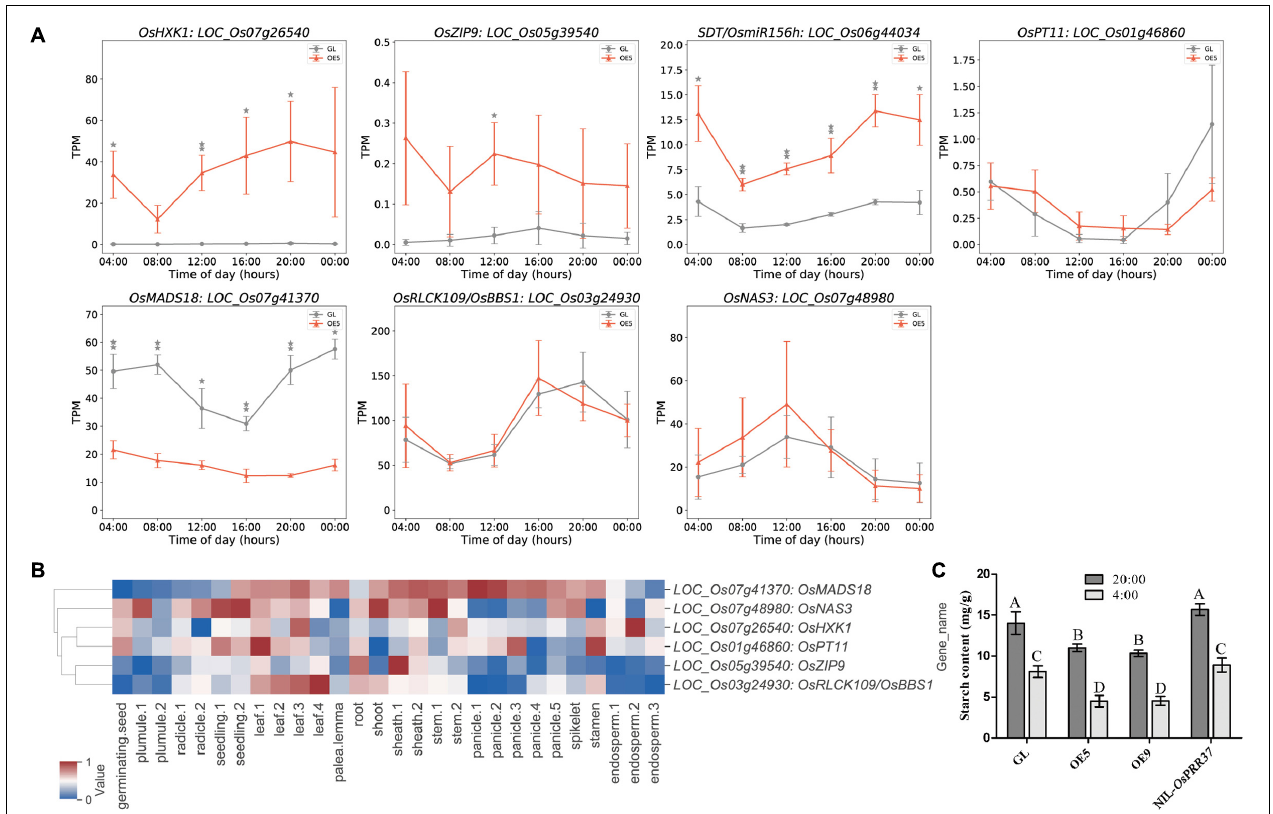
FIGURE 6 | Diurnal and tissue-specific expression analysis of the known overlapping genes. (A) Diurnal expression of the known overlapping genes between DMGs and DEGs. The asterisks above curves mean significance difference at P < 0.05 (one asterisk) and at P < 0.01 (two asterisks). (B) Tissue-specific expression analysis of known overlapping genes. (C) The measure of the starch content in rice leaves at the end (20:00) and beginning (4:00) of the day. Different letters above bars represent significant differences at P < 0.01 as revealed by one-way ANOVA analysis (Bonferroni’s multiple comparison test). Values represent the means ± SD of three